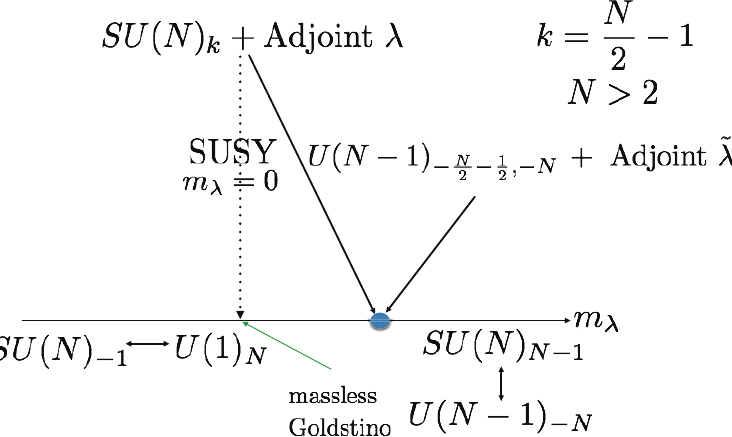
Figure 8: The phase diagram of SU ( N ) with an adjoint fermion and k = N / 2 − 1 and k N > 2. In this theory there is one transition where the infrared TQFT has to change and in addition one point where the Goldstino becomes massless. We propose a fermionic dual for the nontrivial